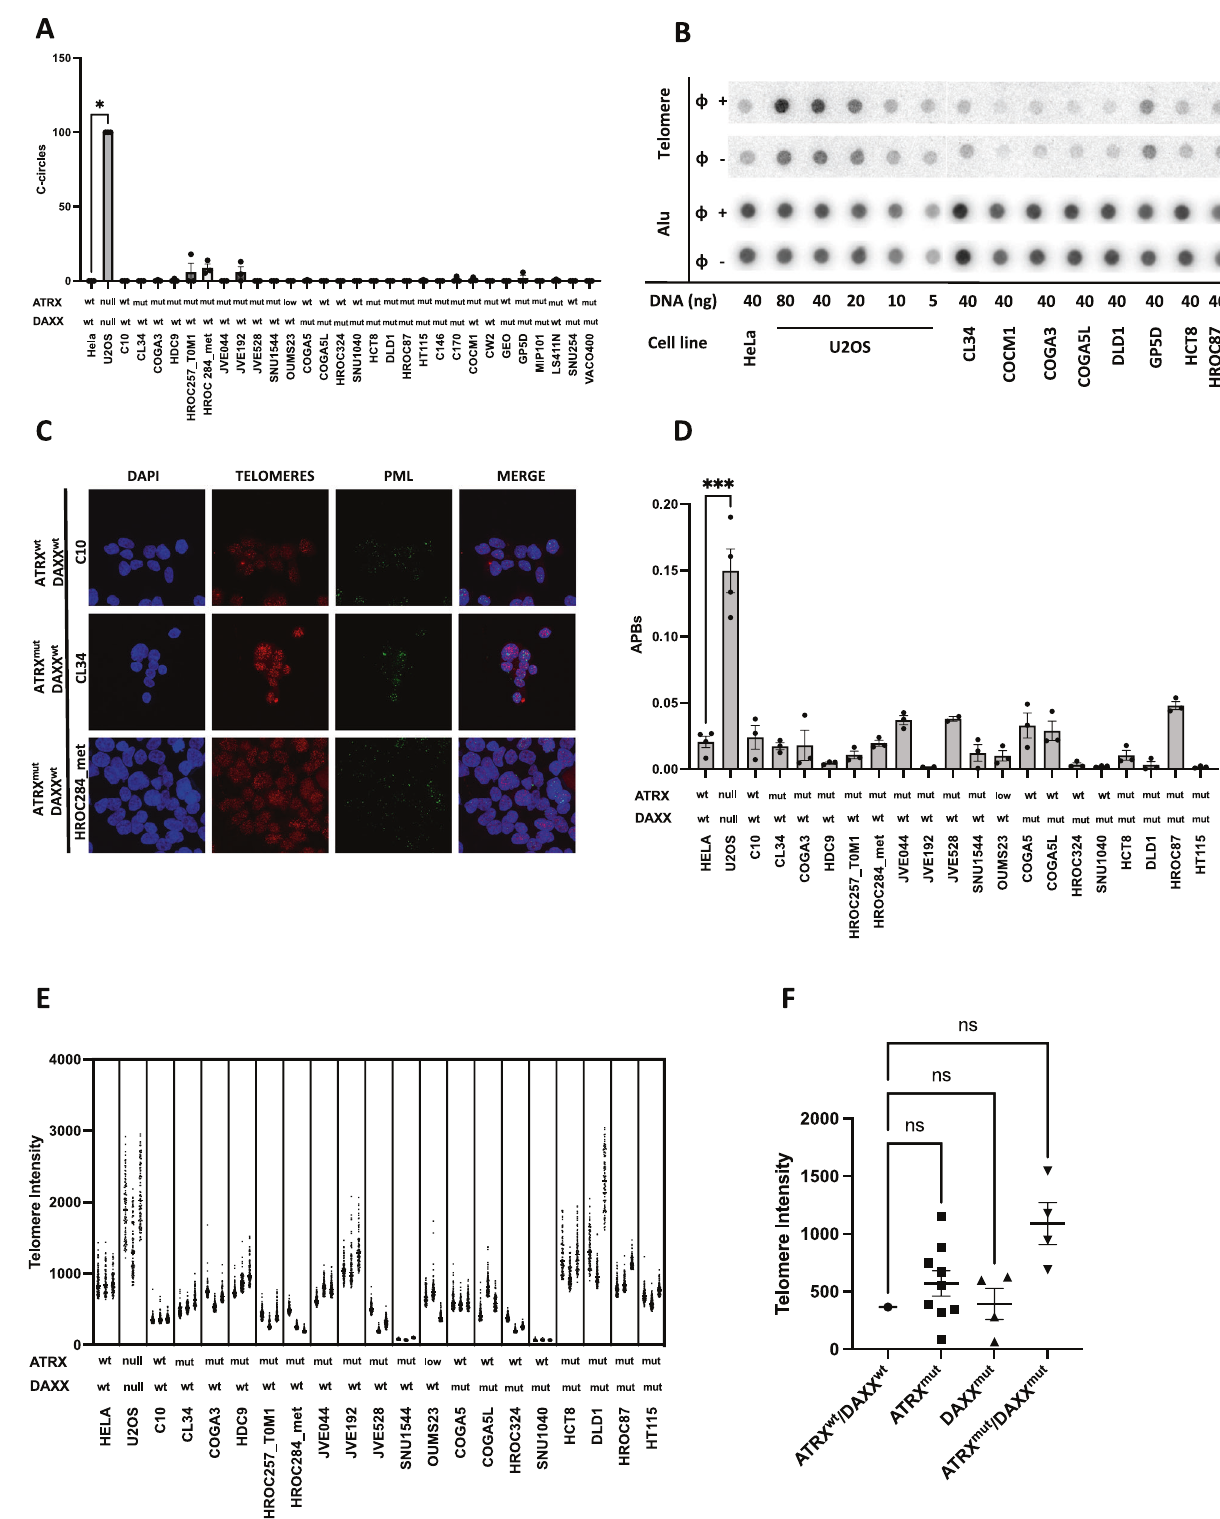
Fig. 2 CRC cell lines do not display ALT markers. A CRC cell lines were tested for C-circles (CCA; n = 3). Quanti fi cation was normalized on ALT + cell line (U2OS). Mean with SEM and individual values are shown. Kruskall – Wallis test, Dunett ’ s multiple comparison test: each column compared with HeLa (* P < 0.033). B Representative dot blot for CCA in cell lines. C Representative images of cell lines screened for telomere intensity and PML, nuclei stained by DAPI. D Number of APBs in selected cell lines (Hela n = 4; other cell lines n = 3). Mean with SEM and individual values are shown. Kruskall – Wallis test, Dunett ’ s multiple comparison test: each column compared with HeLa (*** P < 0.001). E Telomere intensity evaluated in selected CRC cell lines by FISH ( n = 3). F Telomere intensity in cell lines grouped for their ATRX and DAXX mutational status. Each point represents a cell line. Mean with SEM is shown for each group. One-way ANOVA, Dunett ’ s multiple comparison test: each column compared with ATRXwt/DAXXwt (ns = not signi fi cant). U2OS and HeLa cell lines were used as ALT + and ALT- controls in all experiments, respectively. Cell Death and Disease (2023)